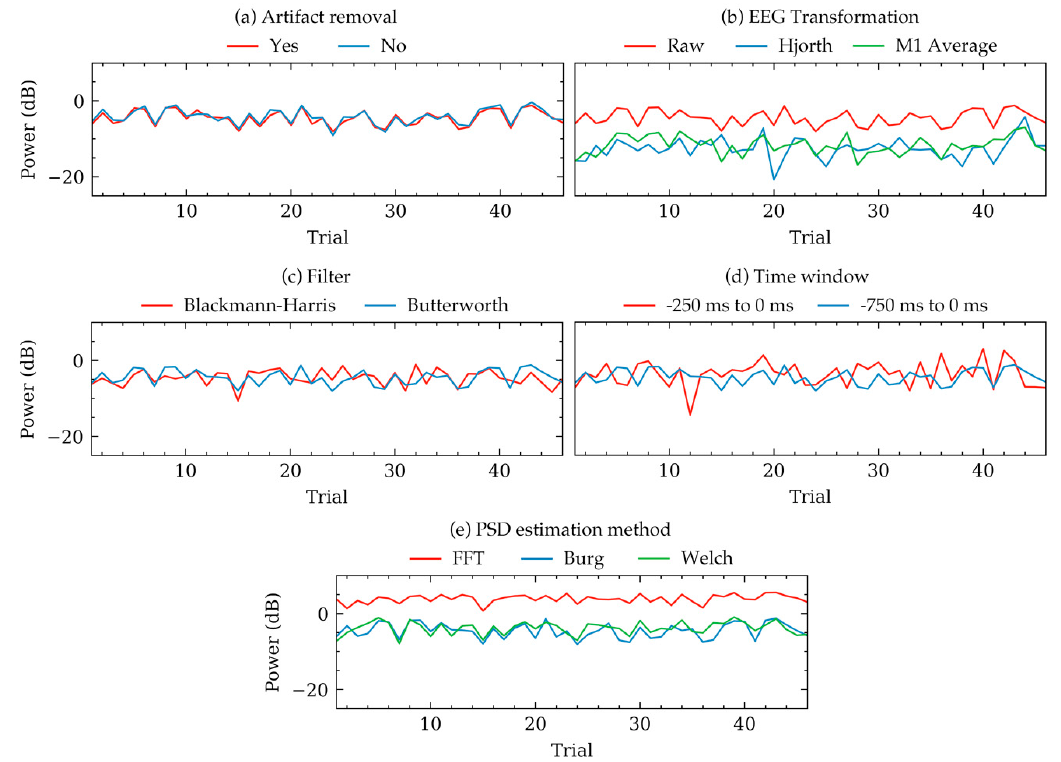
Figure 3. Example variations of PSD quantities of beta band calculated from 46 trials of a random subject in Dataset 1. Each subplot shows how the PSD varied for this subject depending on the selected choices within five methods. Each subfigure contrasts choices in one method keeping the other methods constant to default values. The default constant values were as follows: artifact removal = yes, EEG transformation = raw, filter = Butterworth, time window = 750 ms, method = Welch’s method. ( a ) Variations for artifact removal choices. ( b ) Variations for EEG transformation choices. ( c ) Variations for filter algorithm choices. ( d ) Variations for time window choices. ( e ) Variations for PSD estimation method choices.